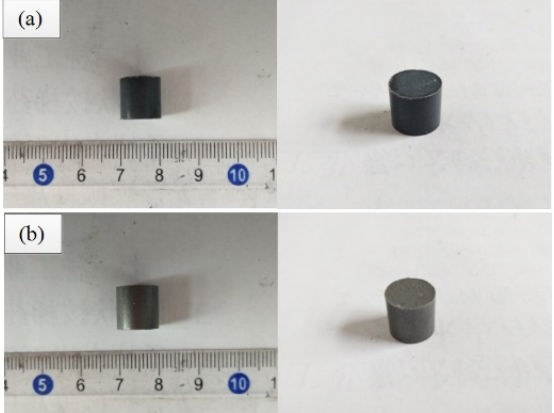
Figure 3. Specimens of two reactive materials before sintering ( a ) Ta/polytetrafluoroethylene (Ta/PTFE) specimen ( b ) Al/Ta/PTFE specimen.